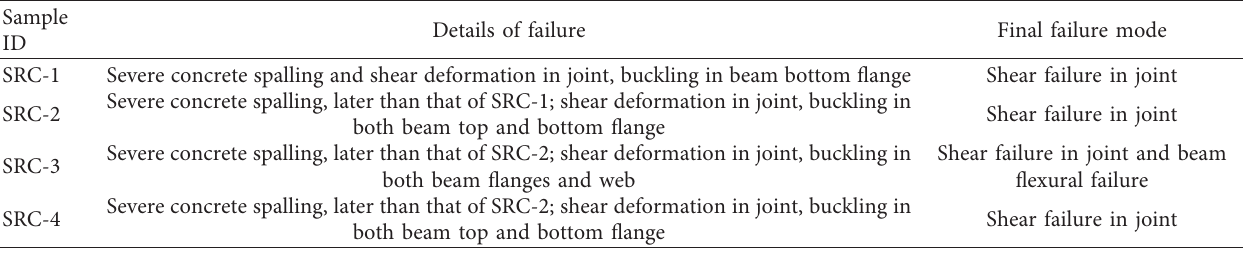
Figure 8: Failure modes of SRC-3. (a) Top flange buckling of beam. (b) Web buckling of beam. (c) Final failure mode. Table 3: Failure modes of all specimens.